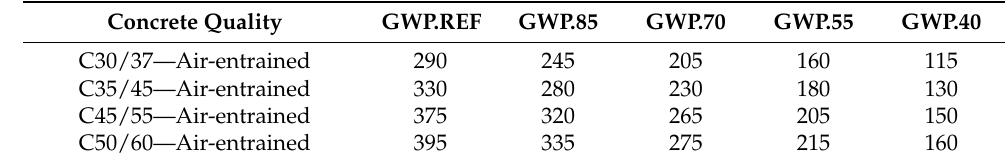
Table 8. Concrete types included in the BY low-carbon classification and limit values for low-carbon classes in Finland [12].